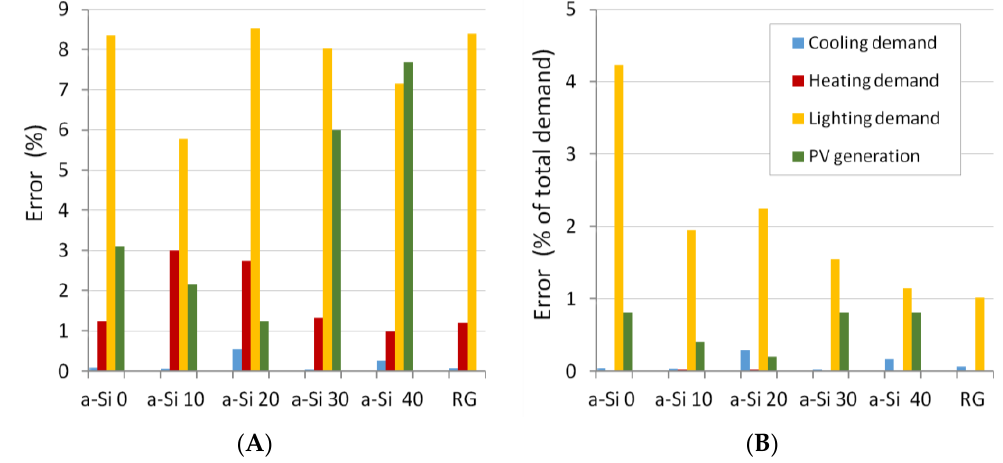
Figure 4. Simulation errors between Energy Plus and IDA ICE evaluated on the validation case of Madrid. ( A ) Percentage error normalized to the specific energy demand. ( B ) Percentage error evaluated